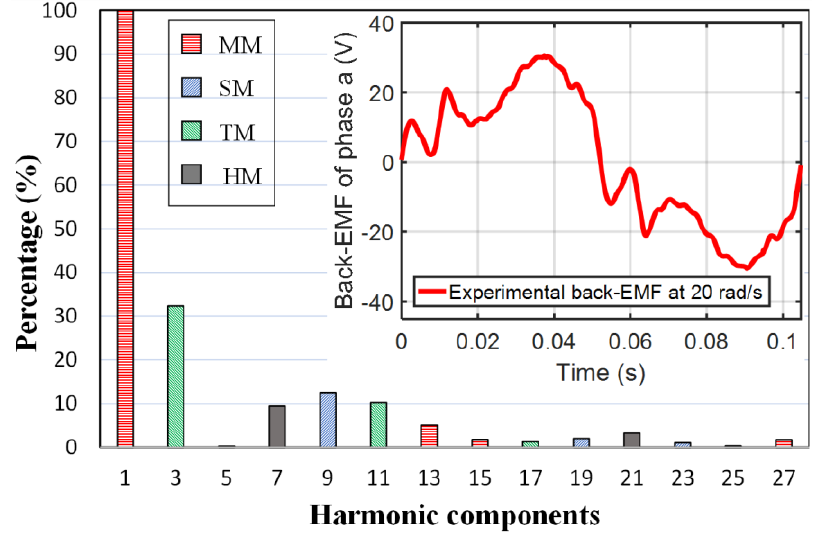
Figure 3. Waveform and harmonic spectrum of the experimental back EMF of phase “a” at 20 rad/s [34].